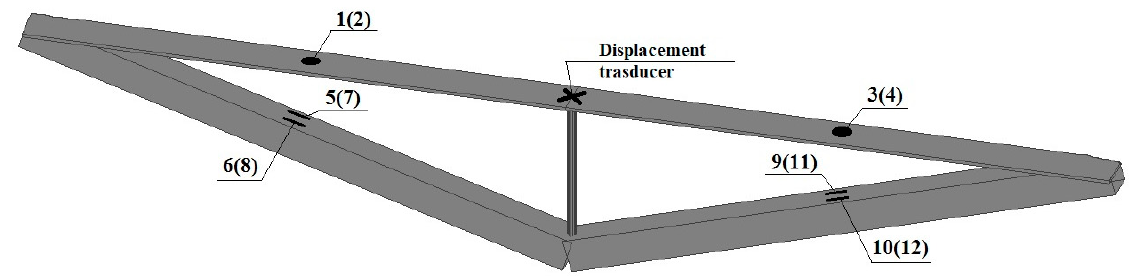
Figure 5. Layout and numbering of sensors on the truss in experiment No. 1.